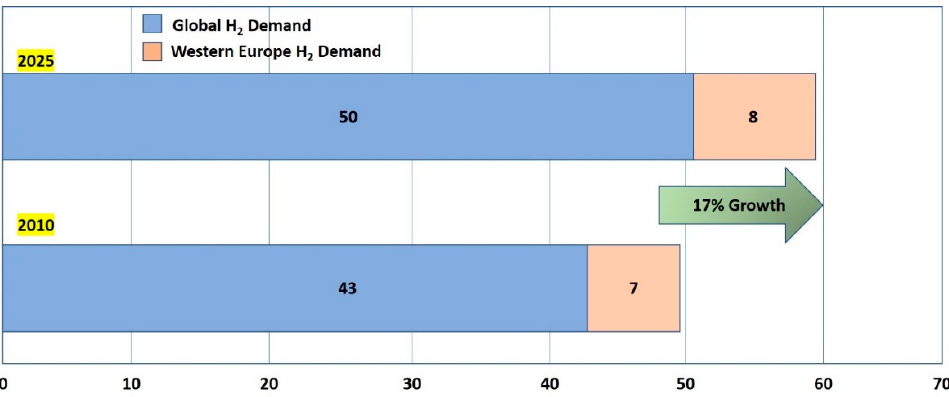
Figure 1. Hydrogen consumption (in millions of Tons) for the year 2010 (below) and the forecast for the year 2025 (up).